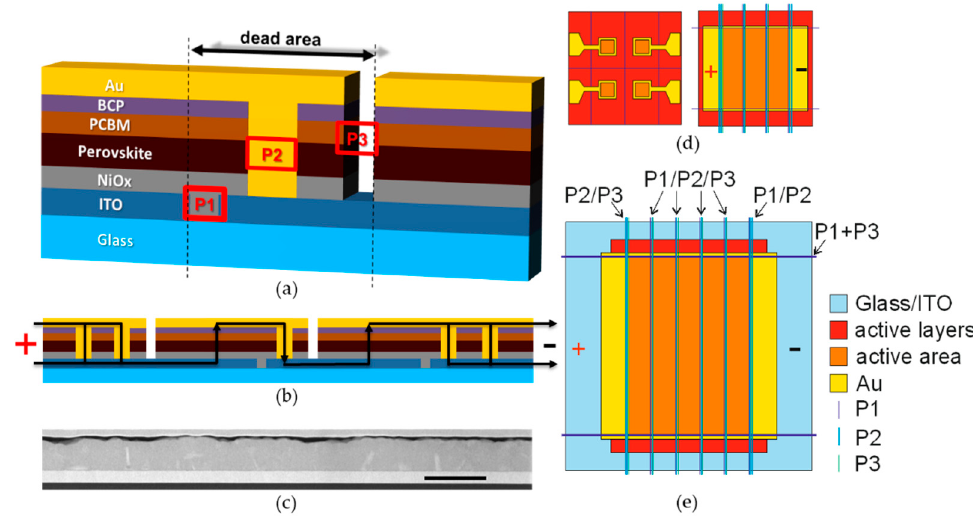
Figure 1. ( a ) A scheme of the pin architecture used and of the P1 P2 P3 interconnection; ( b ) A scheme of the charge flow in the series connection among cells and toward the contact; ( c ) Cross-sectional STEM-HAADF image of the stack used (scale bar is 1 μ m); ( d ) design of the 0.09 cm 2 cell and of the 2.25 cm 2 modules; ( e ) Design of the 10.2 cm 2